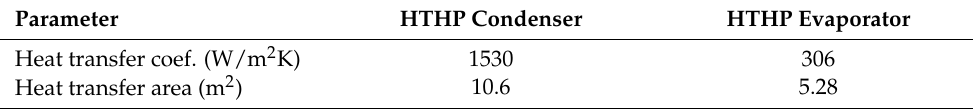
Table 2. Geometric characteristics of the heat pump’s evaporator and